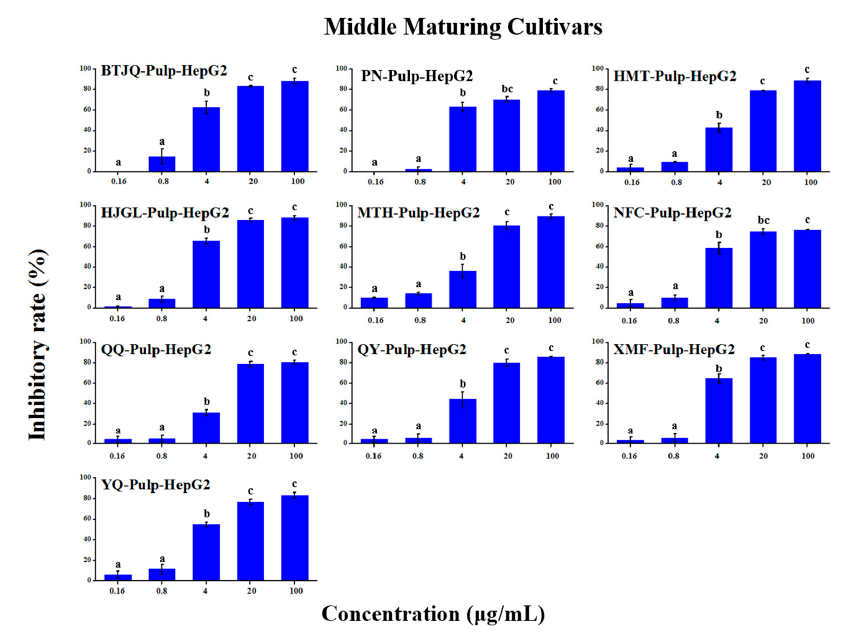
Figure 7. HepG2 growth inhibition effect of pulp extracts from middle maturing cultivars.The names of apple cultivars were showed as abbreviations: PN for ‘Poland No.8’, SS for ‘Sourthern Snap’, QQ for ‘Qianqiu’, GL for ‘Gala’, HMT for ‘Hermhut’, XMF for ‘Ximengfei’, ST for ‘Sakata Tsugaru’, YQ for ‘Yingqiu’, MTH for ‘Mantanghong’, QY for ‘Qiuying’. Different lowercase letters above the bars indicated significant differences at the 0.05 probability level by Tukey test.